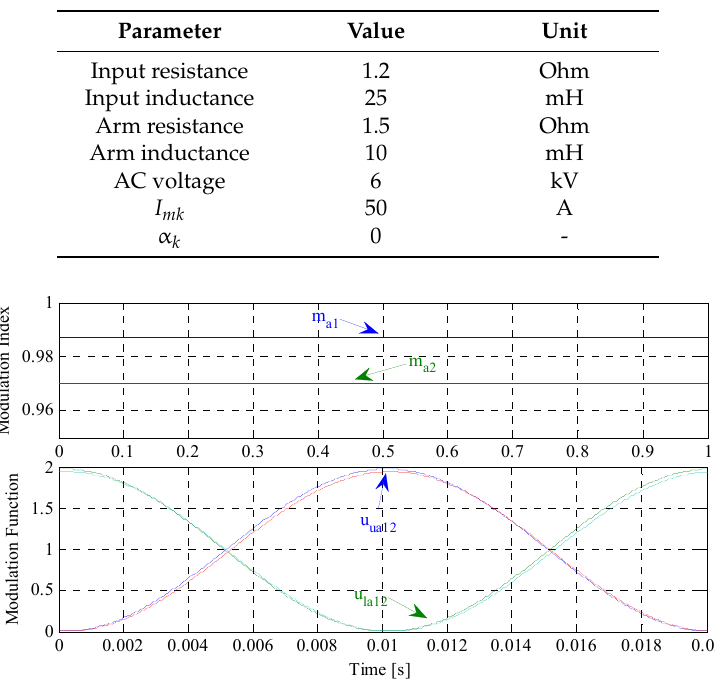
Table 2. Changes in MMC parameters in Condition 2.